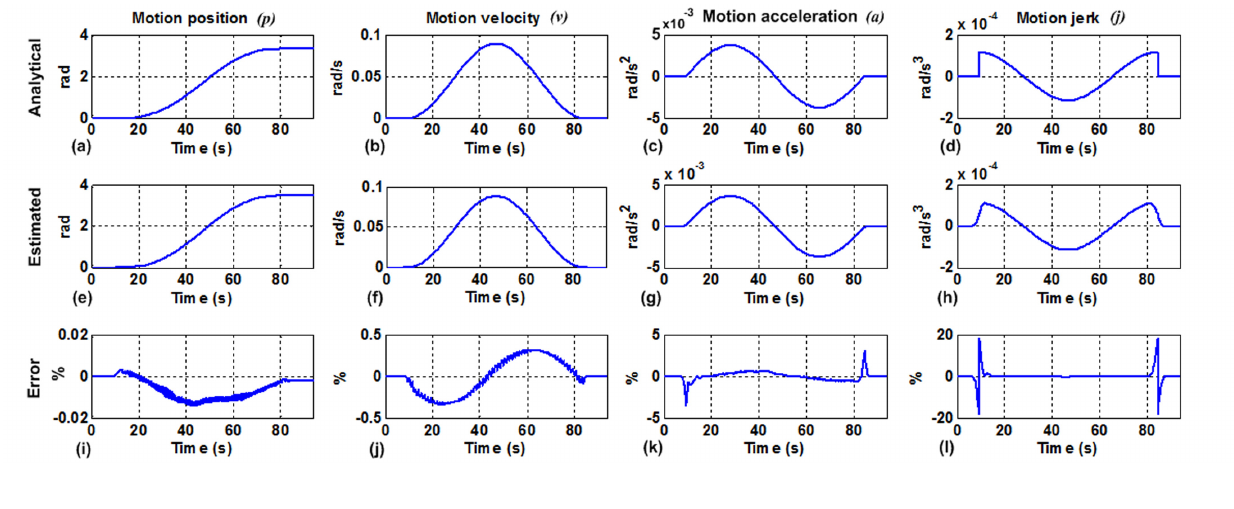
Figure 9. Motion dynamics results: (a) analytical position profile, (e) estimated position profile, (i) position error, (b) analytical velocity profile, (f) estimated velocity profile, (j) velocity error, (c) analytical acceleration profile, (g) estimated acceleration profile, (k) acceleration error, (d) analytical jerk profile, (h) estimated jerk profile, and (l) jerk